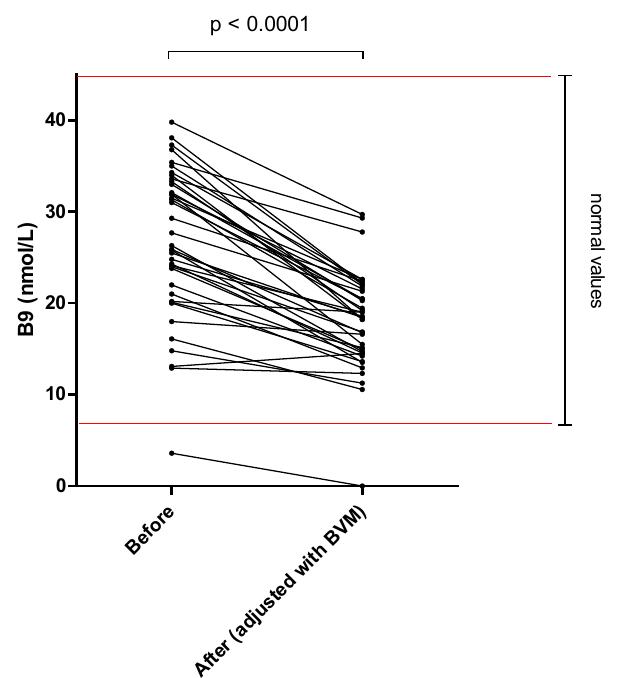
Figure 3. Vitamin B6 (pyridoxal phosphate) blood concentration before and after one 4 h-HDF session (paired t -test).